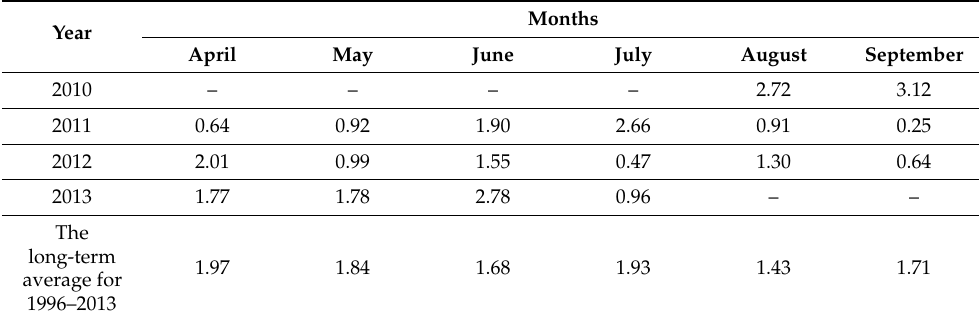
Table 4. Selyaninov’s hydrothermal coefficient (K) in 2010–2013 compared to the long-term average